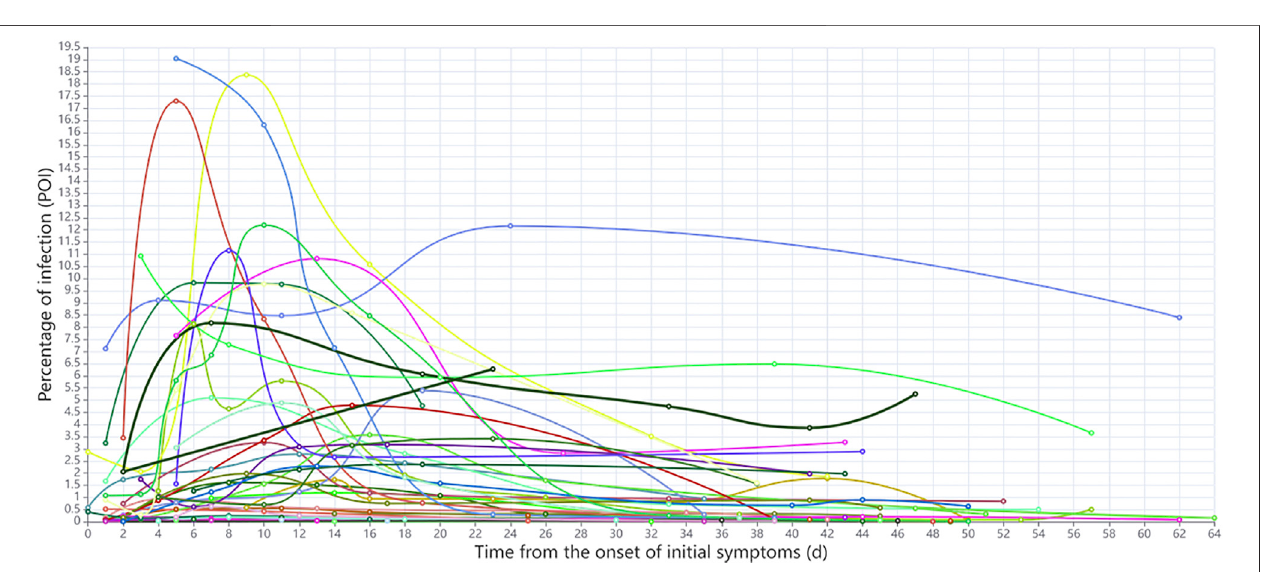
FIGURE 5 | Dynamic changes of POI values since initial symptoms onset in each patient.